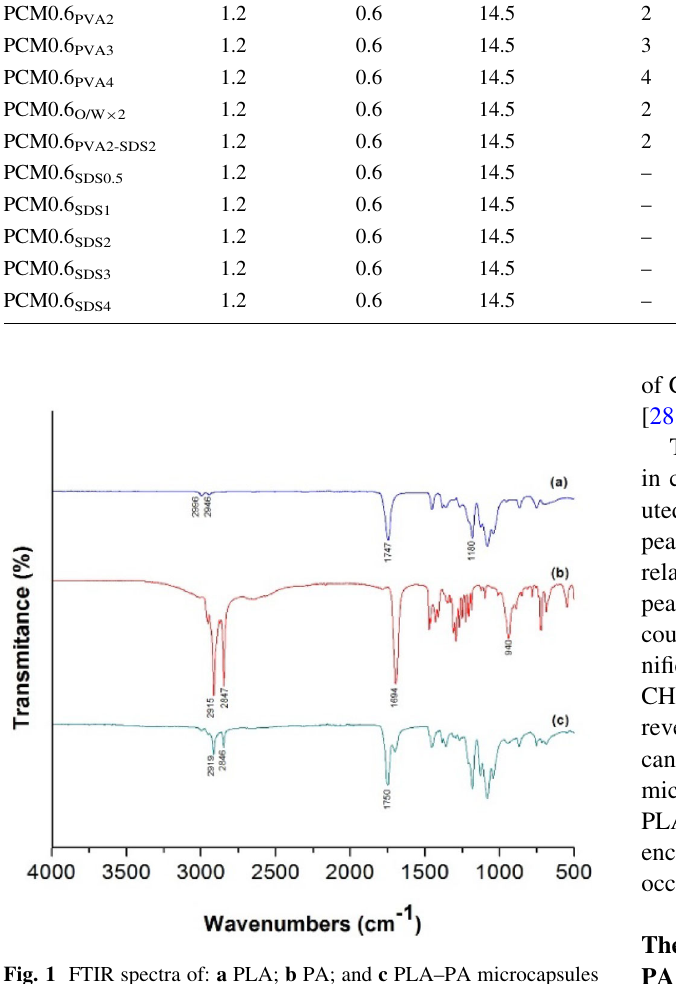
Fig. 1 FTIR spectra of: a PLA; b PA; and c PLA–PA microcapsules